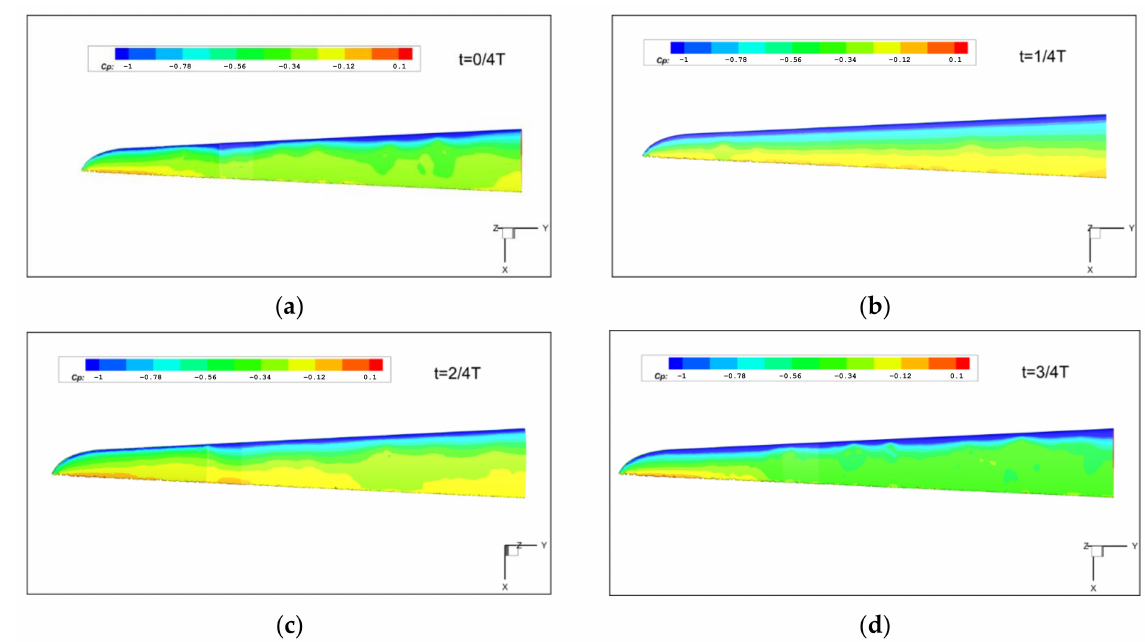
Figure 21. Pressure distribution of spanwise morphing wing at 10 ◦ AOA. ( a ) Time of 0/4 T, ( b ) time of 1/4 T, ( c ) time of 2/4 T and ( d ) time of 3/4 T.